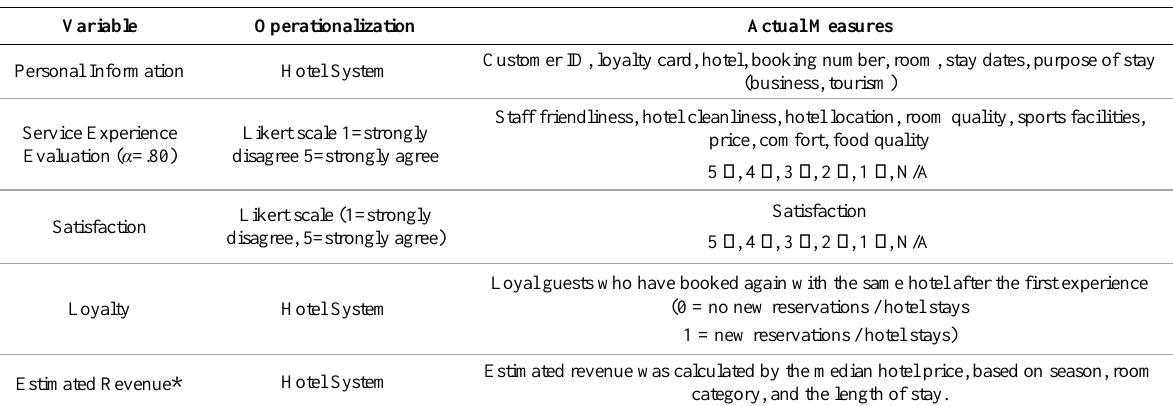
Table 1. Survey measures